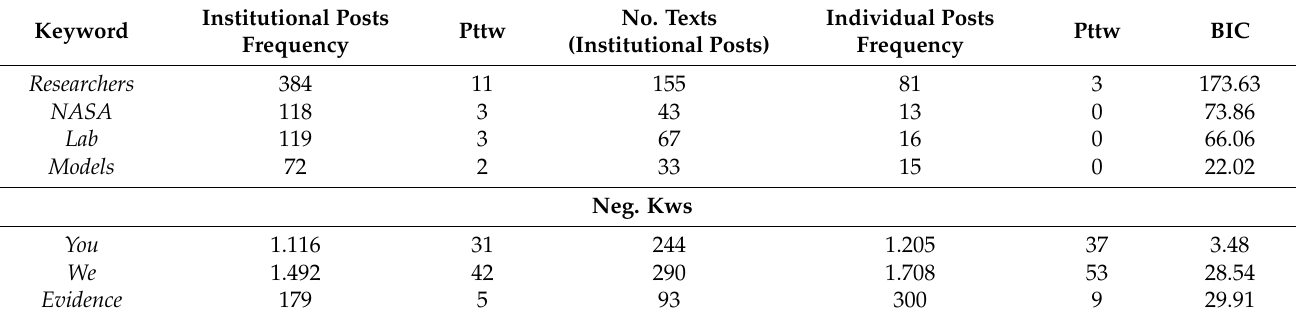
Table 3. Institutional vs. individual blog posts: other participant-related